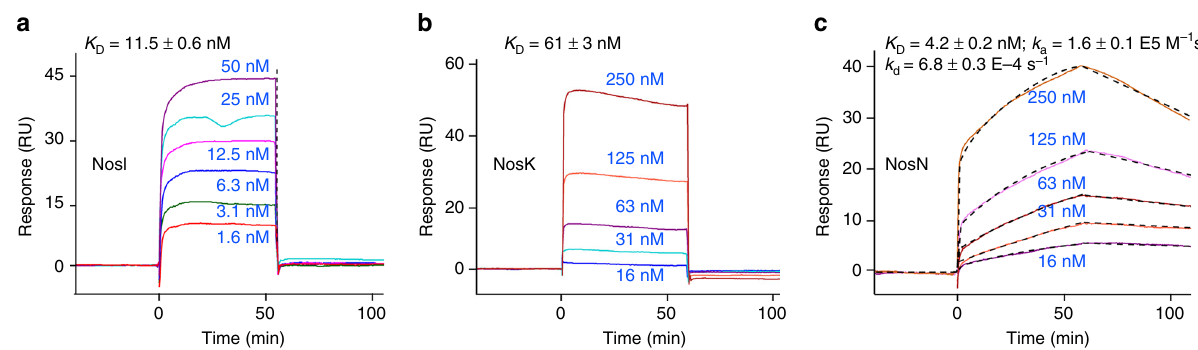
Fig. 6 SPR measurements of NosJ binding to its reaction partners. NosI a and NosK b showed rapid binding and dissociation kinetics, whereas NosN c showed a relatively slow kinetics. K D represents equilibrium dissociation constant, whereas k a and k d represent the rate constants of association and dissociation, respectively. Sensorgrams are shown in solid lines with different colors corresponding to different concentrations, and the fi ttings in c are shown in dashed black lines